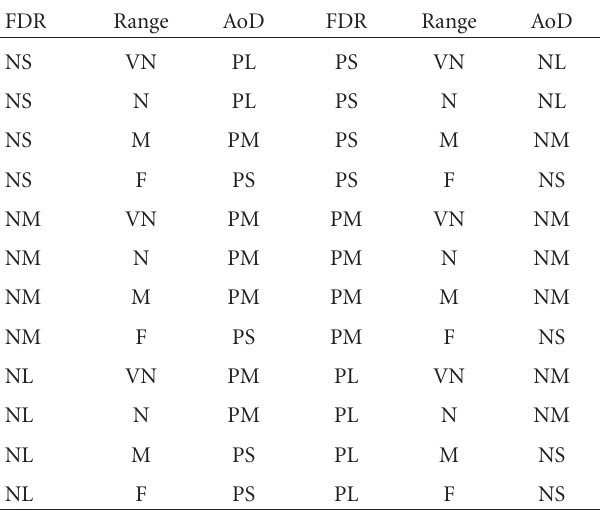
Table 1: The rule base of collision avoidance